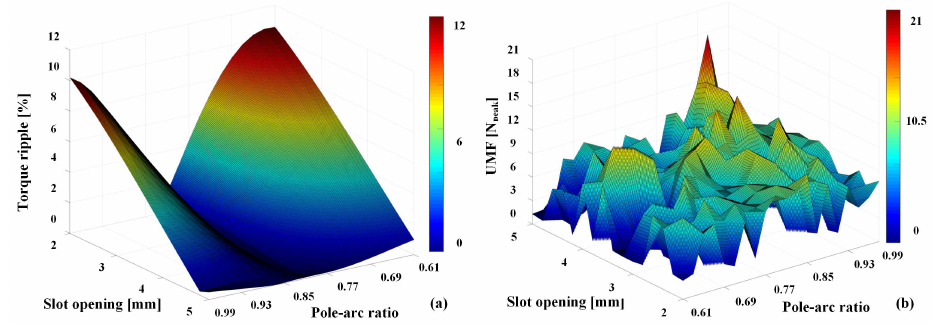
Figure 10. Parametric analysis under the rated-load condition: ( a ) torque ripple; ( b )